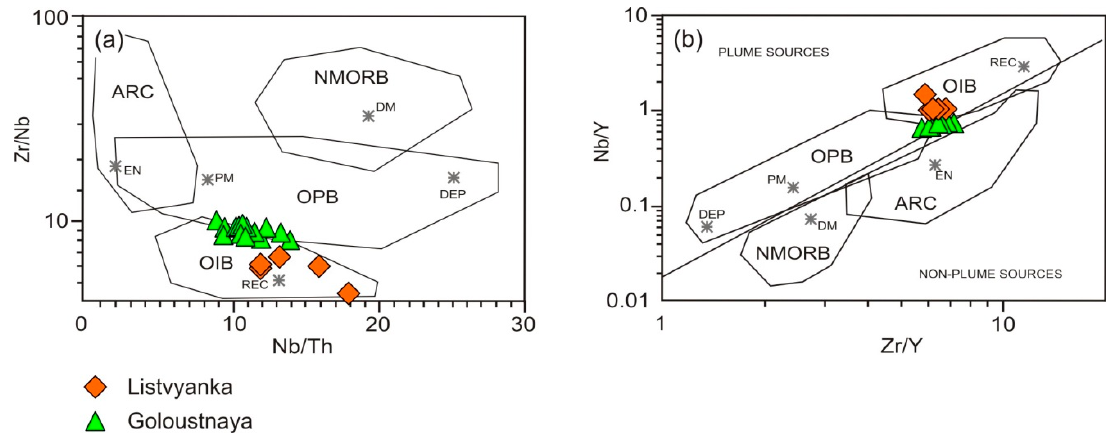
Figure 10. Zr/Nb–Nb/Th ( a ) and Nb/Y–Zr/Y ( b ) diagrams [38] for Listvyanka and Goloustnaya dolerites. Abbreviations: ARC, arc-related basalts; NMORB, normal mid-ocean ridge basalts; OIB, oceanic island basalts; OPB, oceanic plateau basalts. DM, shallow depleted mantle; PM, primitive mantle; DEP, deep depleted mantle; REC, recycled component; EN, enriched component.